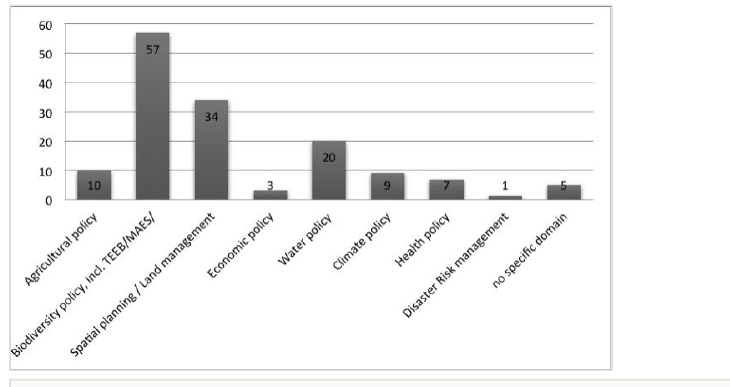
Figure 12. Policy and business domains included in the database in which the mapping and assessment methods were applied.